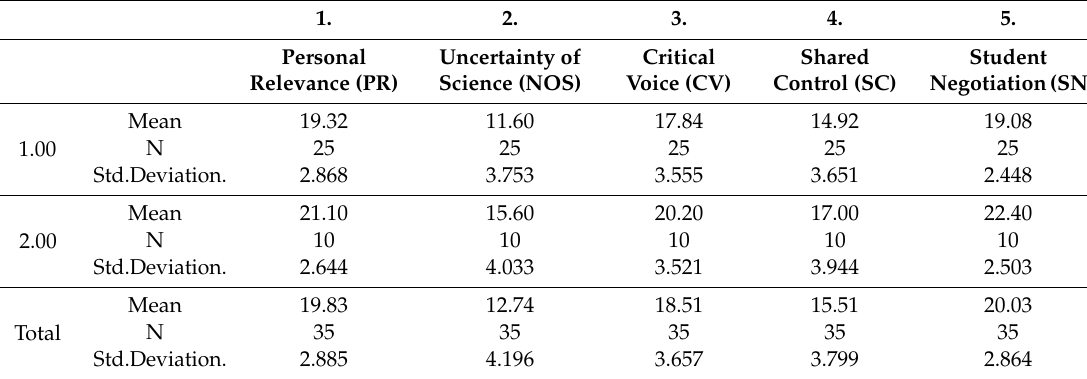
Table 1. High (2) and low (1) idealism, and aspects of constructivism.